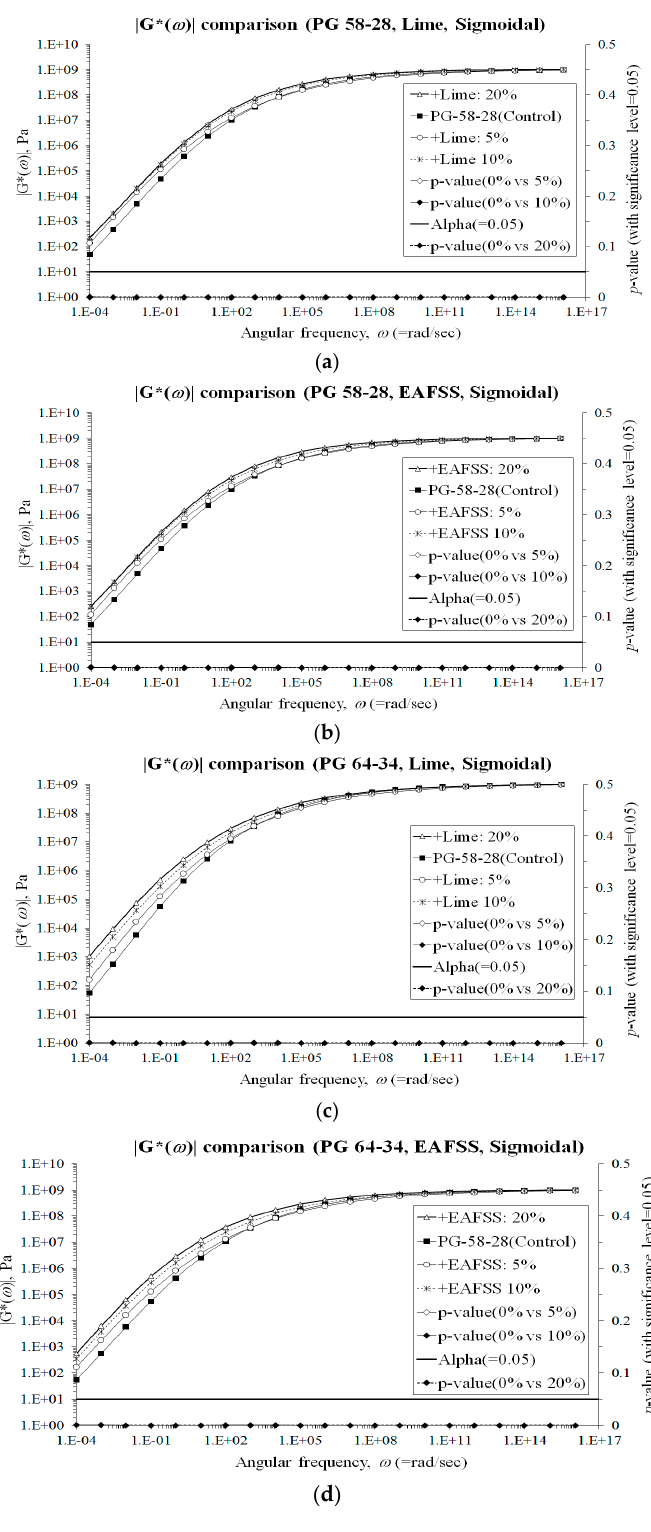
Figure 10. | G* ( ω )| comparisons by using the sigmoidal function [45]. ( a ) | G* ( ω )| comparisons (PG 58-28, Lime, Sigmoidal); ( b ) | G* ( ω )| comparisons (PG 58-28, EAFSS, Sigmoidal); ( c ) | G* ( ω )| comparisons (PG 64-34, Lime, Sigmoidal); ( d ) | G* ( ω )| comparisons (PG 64-34, EAFSS, Sigmoidal).